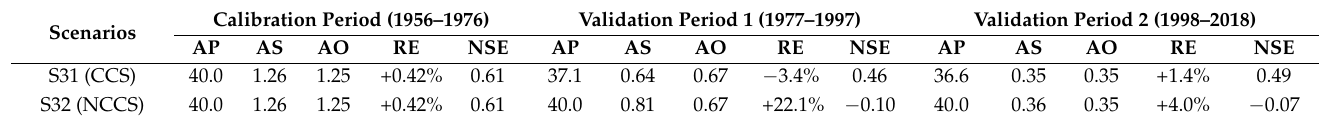
Table 7. Simulated results of S3.